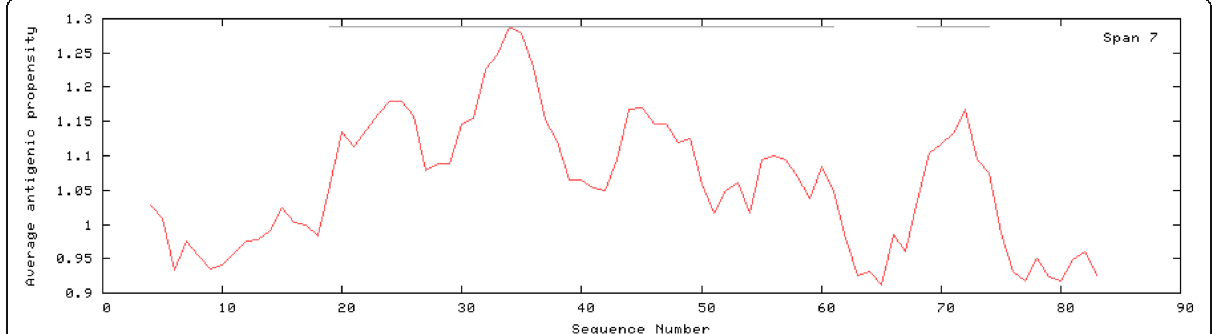
Fig. 7 Antigenicity plot and antigenic determinants of EhApc11. Two antigenic determinants (spanning the regions 19 – 61 and 68 – 74) are indicated by grey lines within the plot